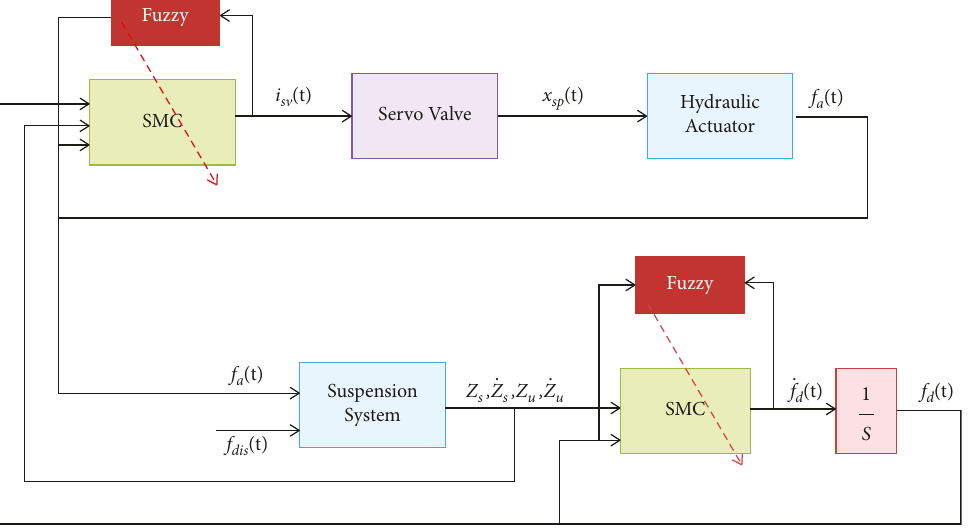
Figure 5: Block diagram of the proposed control